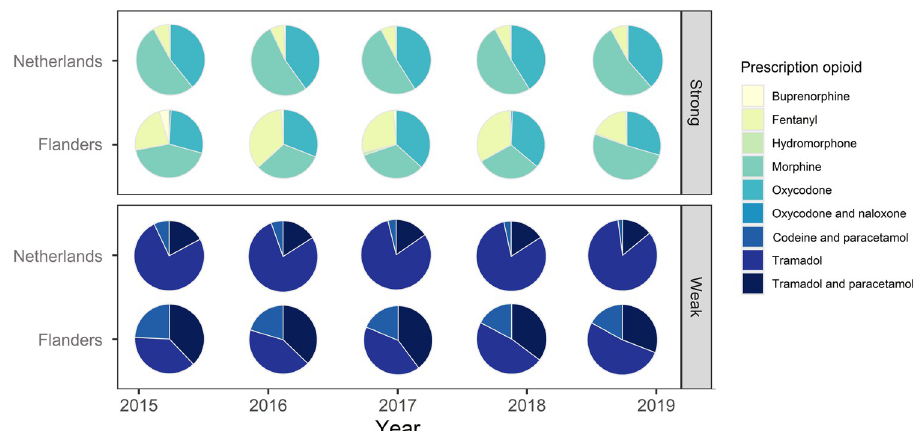
Fig 2. Distribution of type of opioid prescribed in out-of-hours primary care, separately for strong (upper panel) and weak opioids (lower panel) in Flanders and the Netherlands. The figure does not reflect the relative proportions in prescribing of weak and strong opioids over time (see Fig 1).